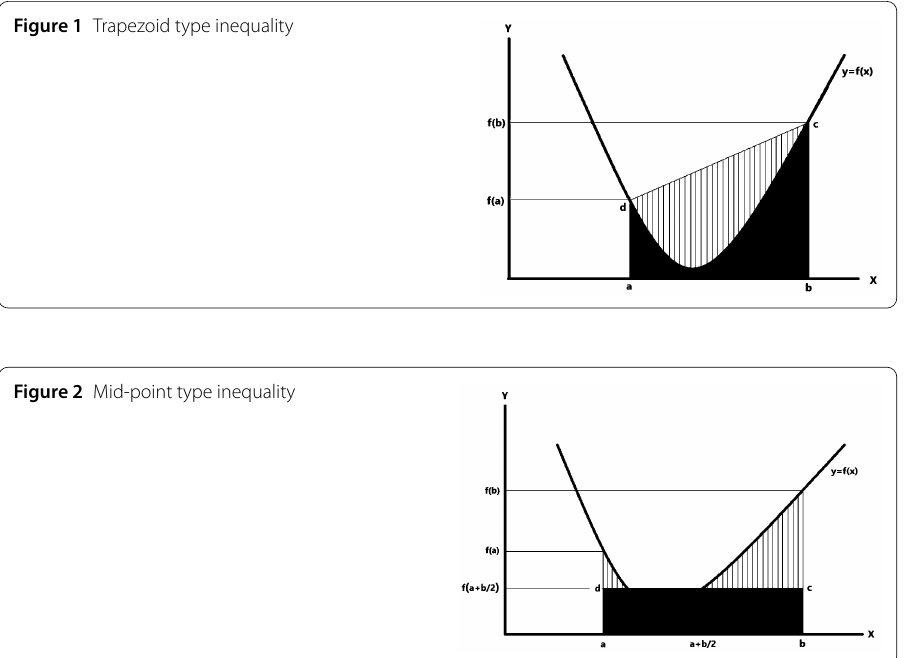
Figure 1 Trapezoid type inequality